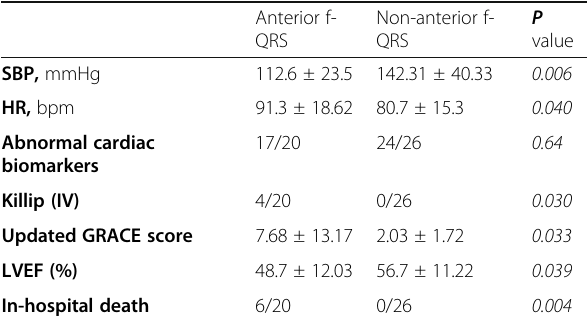
Table 4 Relations between anterior f-QRS and some important medical results in the cases group